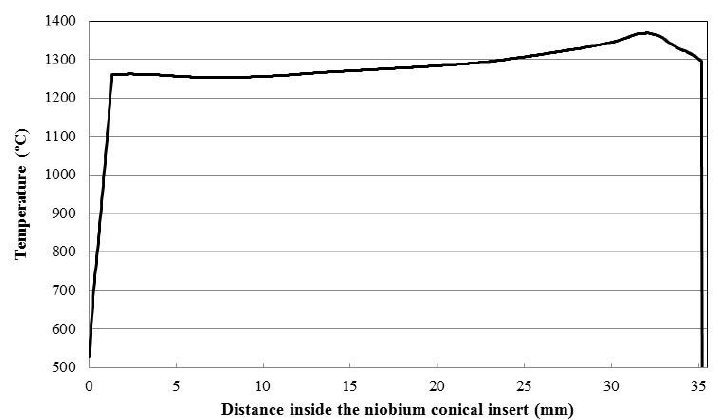
Figure 10. Temperature of the liquid target at the axis of the cavity, along the beam patch.